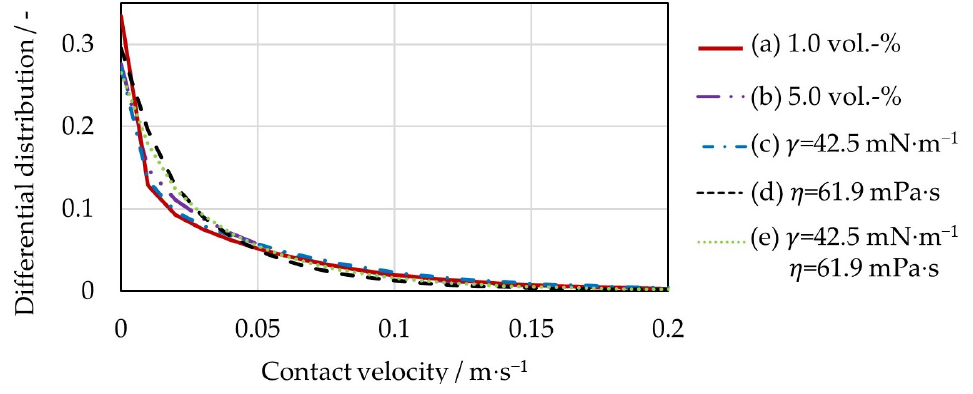
Figure 9. Differential distribution of the contact velocities for the five simulation cases.